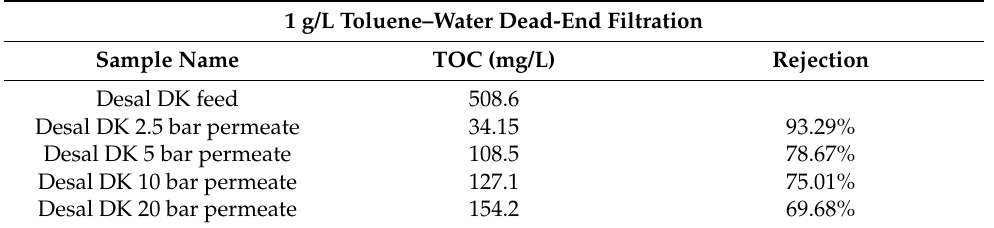
Table 4. TOC data for dead-end filtration of the Bedfordshire site water. 1 g/L Toluene–Water Dead-End